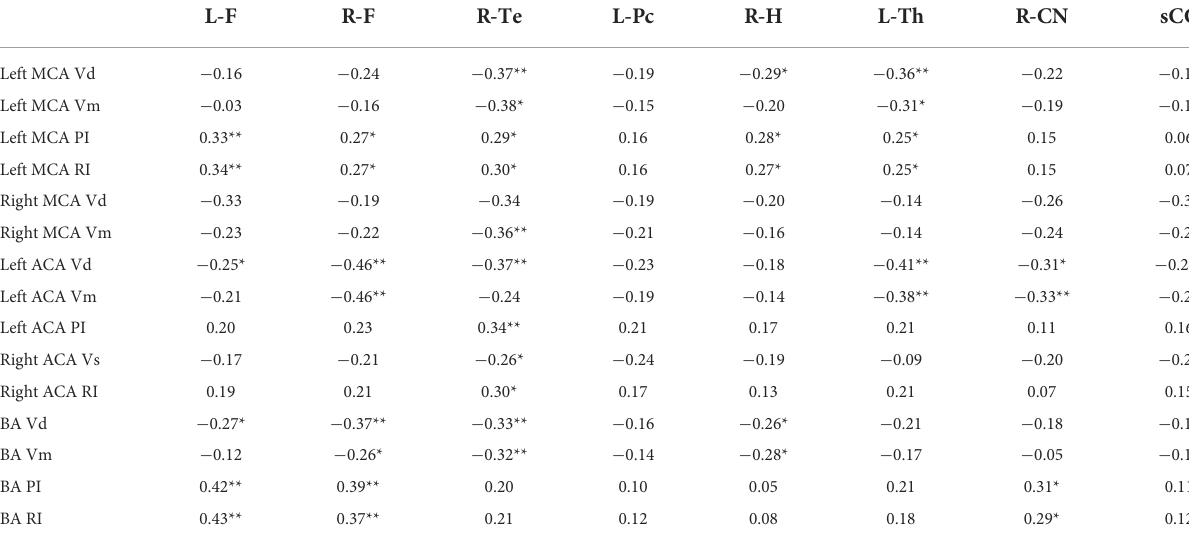
TABLE 6 Pearson’s correlations between T1 relaxation times and TCD parameters.